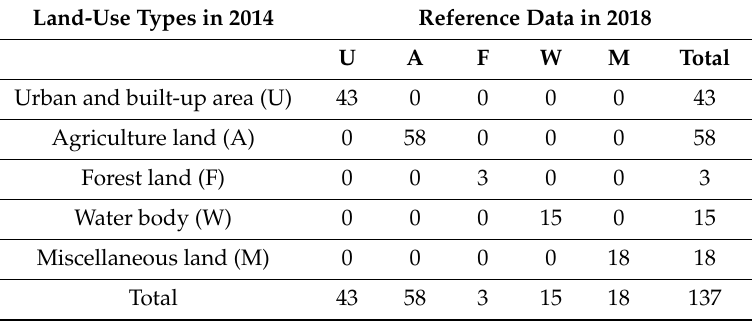
Table A2. Error matrix for accuracy assessment of land-use types in 2014. Land-Use Types in